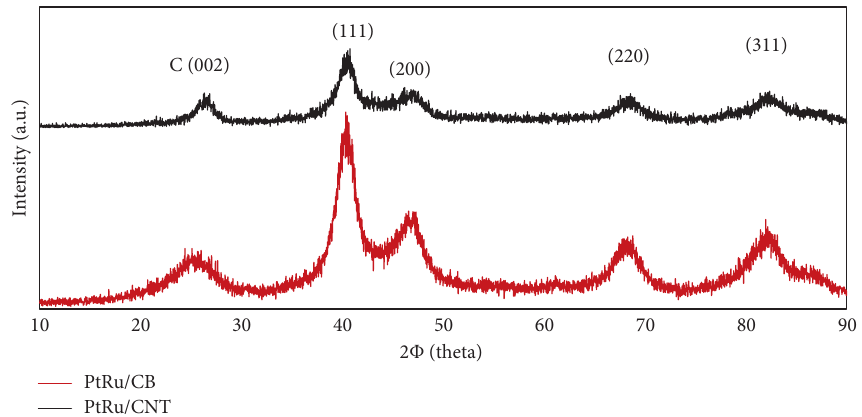
Figure 4: The XRD patterns of the synthesized samples for the